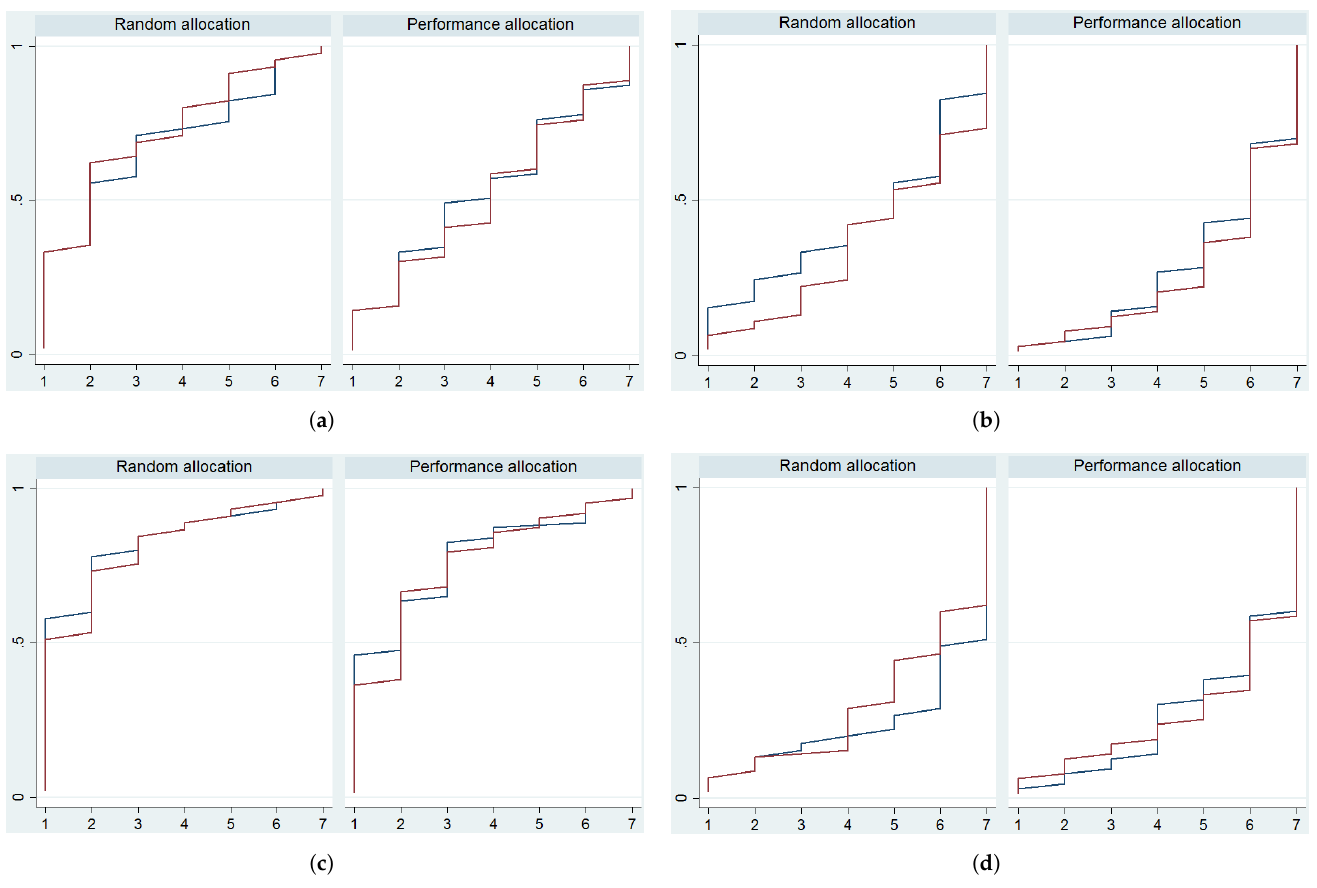
Figure 3. Equity judgements. Each subplot shows the CDF of low-income taxpayers’ ratings of agreement (1 = “Do not agree at all”, ..., 7 = “Completely agree”) to statements related to aspects of fairness and adequacy of the experimental tax game. Red and blue lines indicate the CDFs for informed and uninformed taxpayers respectively. Observations are restricted to low-income taxpayers in groups of four and plotted separately for random and performance-based allocation treatments. ( a ) Statement “The role allocation and the resulting income differences in the experiment are fair”; ( b ) Statement “The role allocation in the experiment is fair but income differences are too large”; ( c ) Statement “Taxing participants in role A at 10 percent and participants in role B at 50 percent is fair”; ( d ) Statement “It is not justified that participants in role A have to pay a lower tax